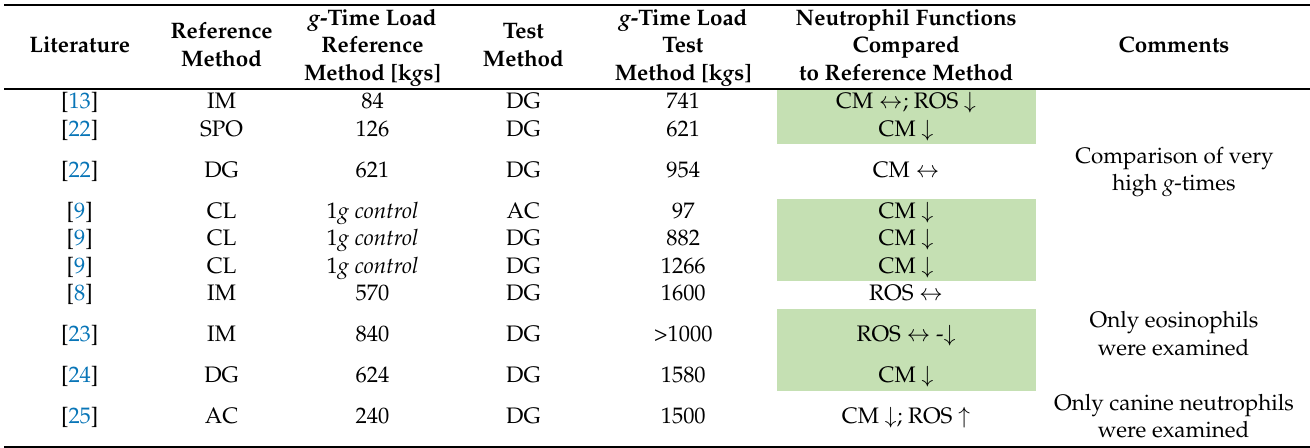
Table 3. Analysis of literature regarding the g -time load of different isolation protocols. The method with less g -time load was set as the reference method in each case. Abbreviations: DG = density gra- dient separation; IM = immunomagnetic separation; SPO = spontaneous sedimentation; CL = blood clot method; AC = ammonium chloride method; CM = chemotactic migration; ROS = s oxidative burst. “ ↑ ” indicates higher, “ ↓ ” indicates lower, “ ↔ ” indicates no change in functions compared to the reference method. Green shaded table elements indicate accordance to our results (“higher g -time impairs neutrophil functions”). Since the reference method (blood clot method) in [9] did not include a centrifugation step, we denominated it as “1 g